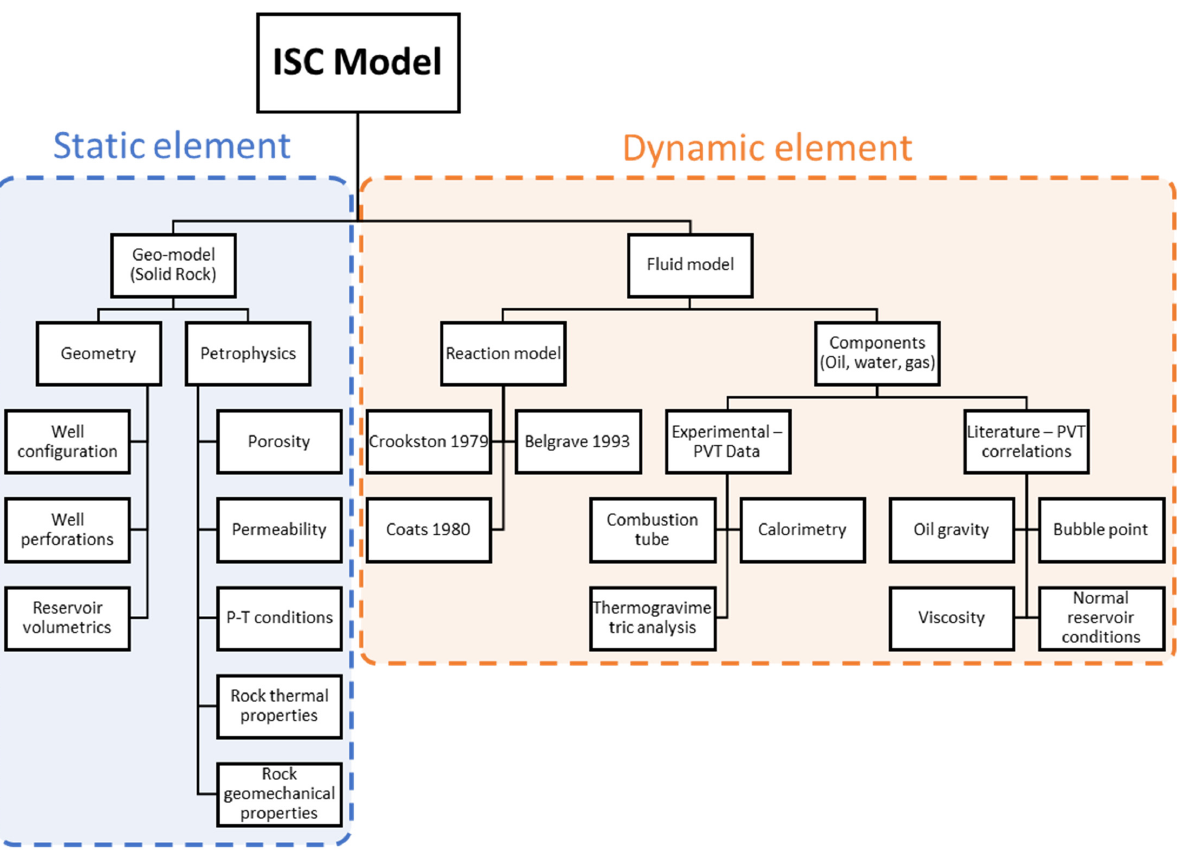
Figure 9. Chart to show the constituent parts of the model, separated into the static and dynamic elements of the model and what data are used to populate the different parts of the model and where those data come from.